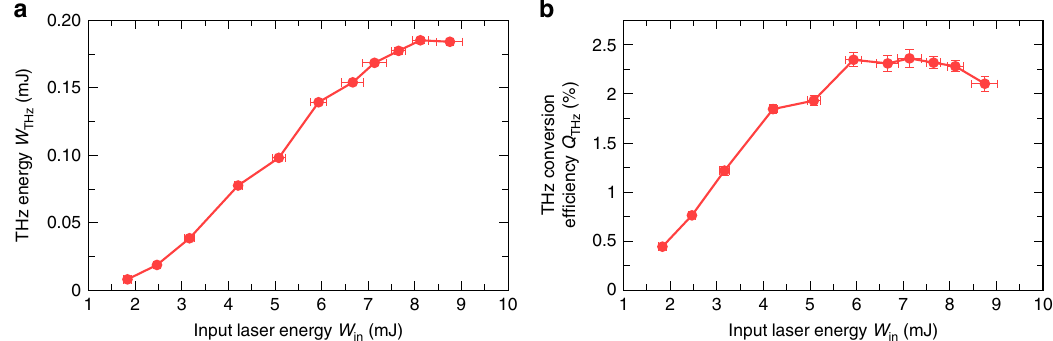
Fig. 2 THz energy and THz conversion ef fi ciency. Dependence of THz energy W THz a and the corresponding THz conversion ef fi ciency Q THz b on the input laser energy W in . Error bars represent the standard deviation over a number of measurements.